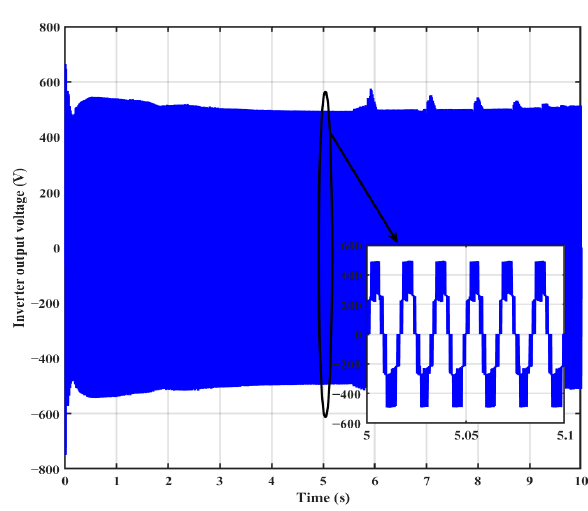
Figure 15. Voltage produced by the inverter.